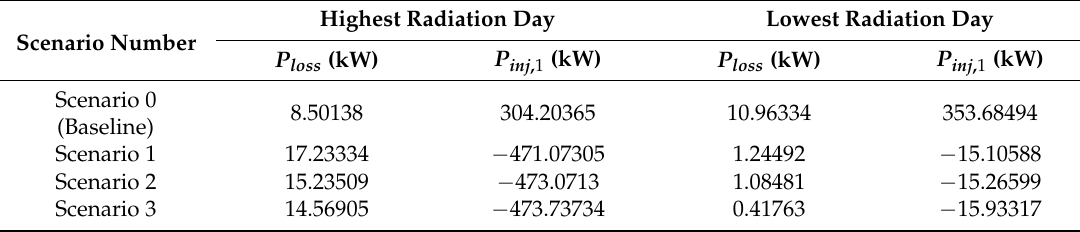
Table 2. Total power and energy losses and power injected from bus 1.